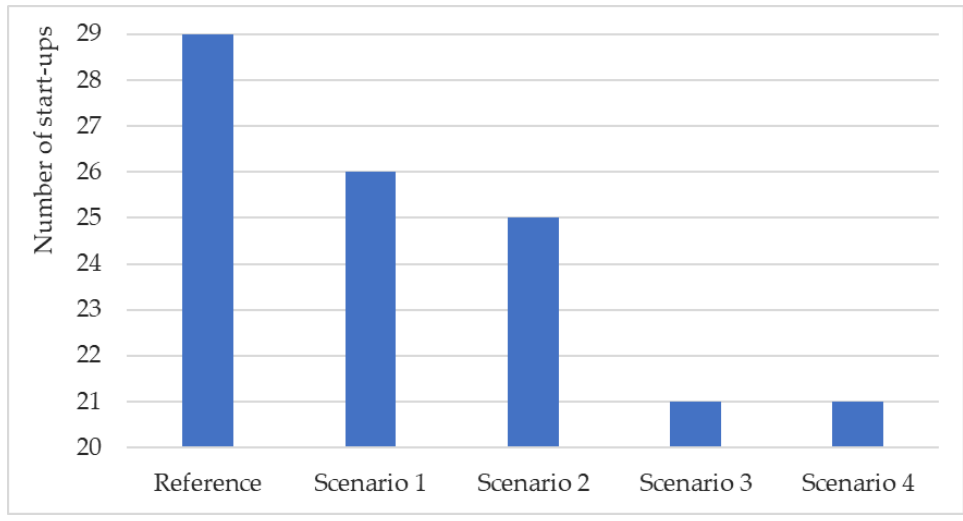
Figure 9. The number of start-ups for main simulations.